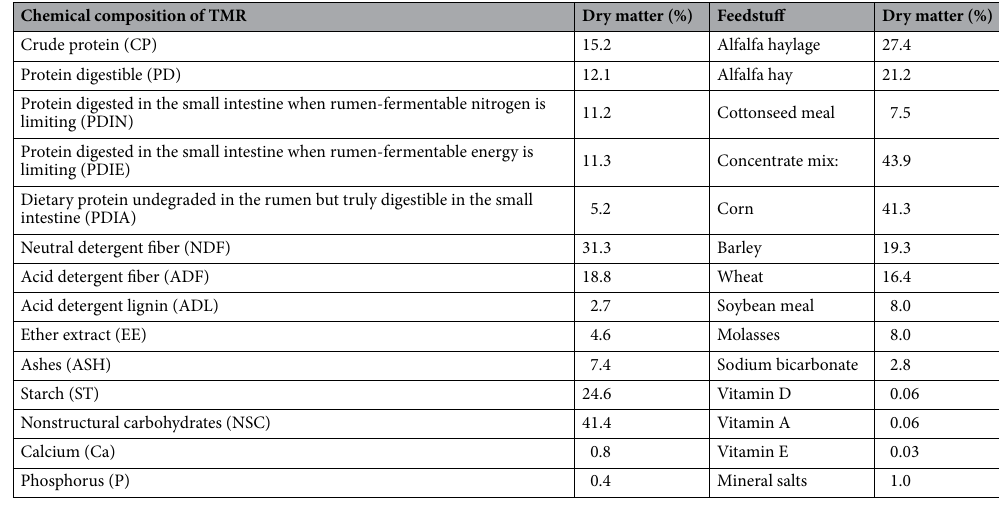
Table 4. Total mixed ratio (TMR) and feedstuffs used for all groups (G0, G1, and